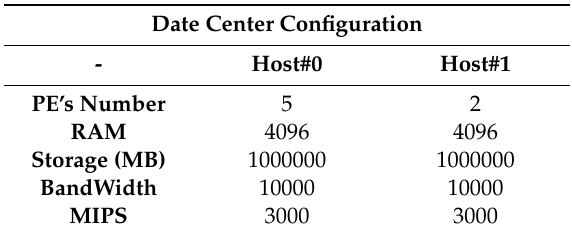
Table 1. Datacenter Configuration.